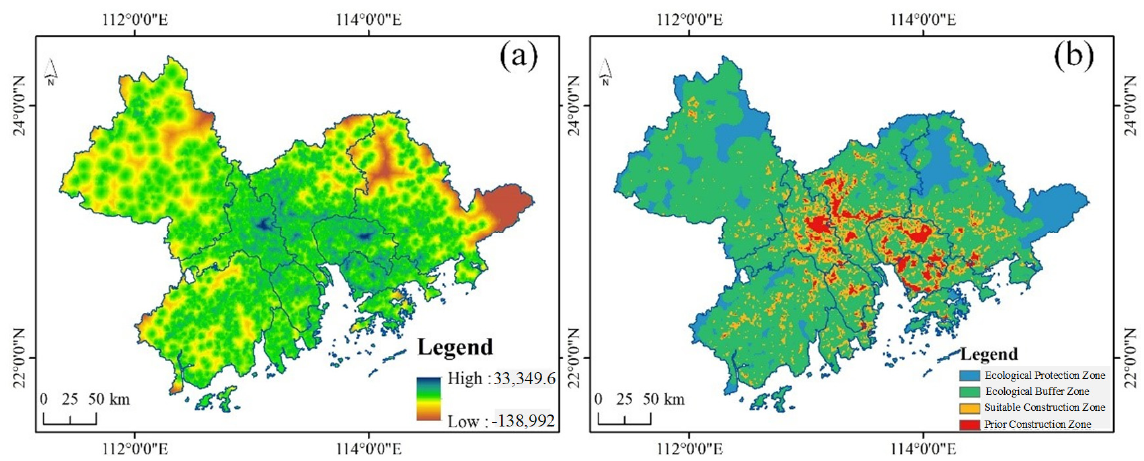
Figure 7. The spatial distribution of MCR surface differences ( a ) and LES zoning of the GBA in 2020 ( b ).